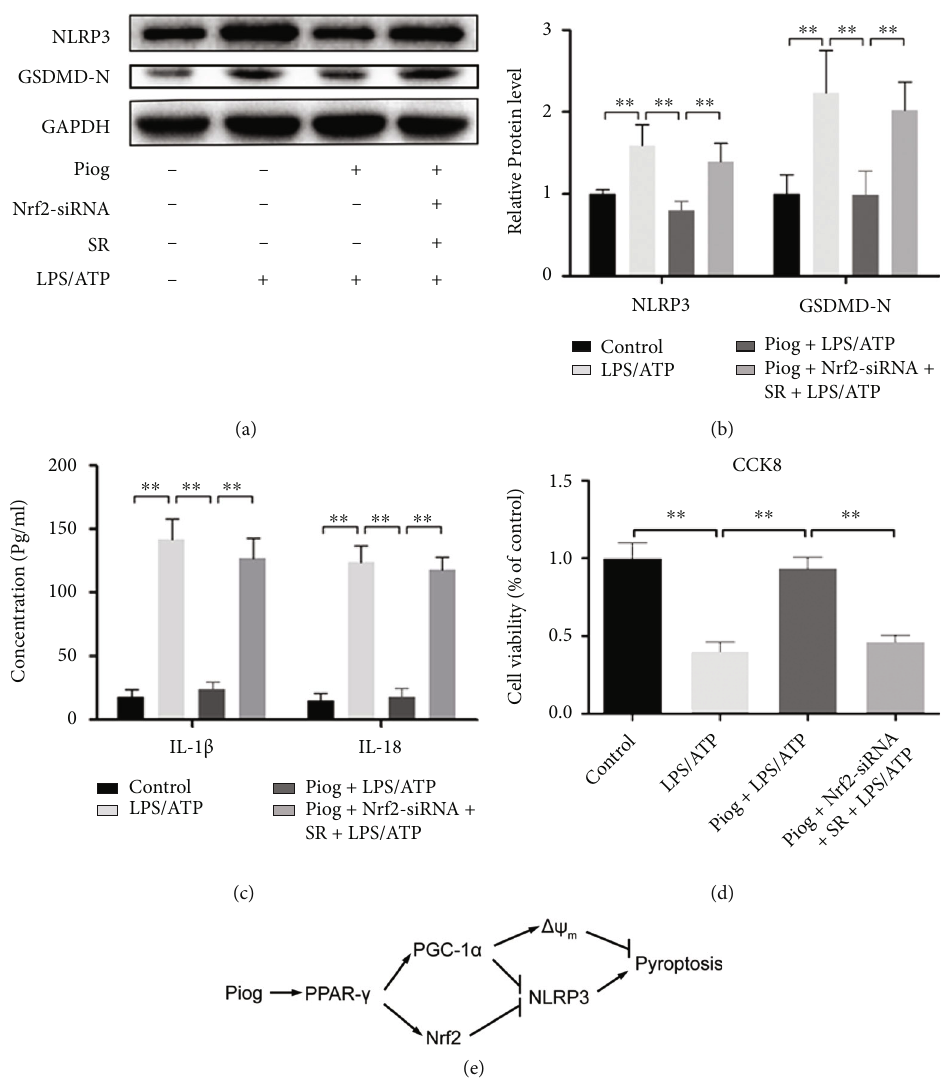
Figure 6: Involvement of Nrf2 and PGC-1 α in the e ff ect of Piog on pyroptosis in the OA chondrocytes. (a and b) Western blotting experiments and densitometric analysis. SR was used as a PGC-1 α inhibitor. Nrf2-siRNA was used for knocking down the level of Nrf2. GAPDH was used as an internal reference. (c) ELISA was used to measure IL-1 β and IL-18 concentrations. (d) CCK8 assays were performed to measure chondrocyte viability. ** P < 0 : 01 , n = 5 . (e) The action mode of PPAR- γ under Piog stimulation to protect from pyroptosis-mediated OA cartilage